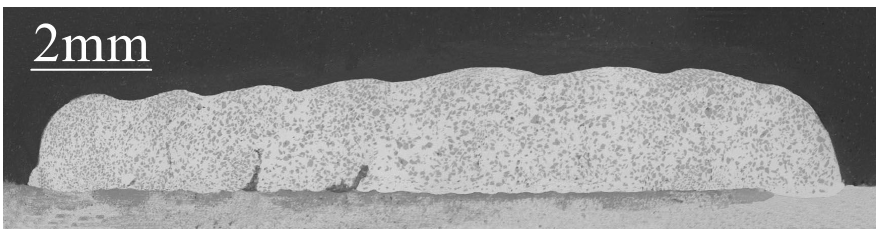
Figure 10. Macrograph of optimized cross sectional multi-pass clad layer.